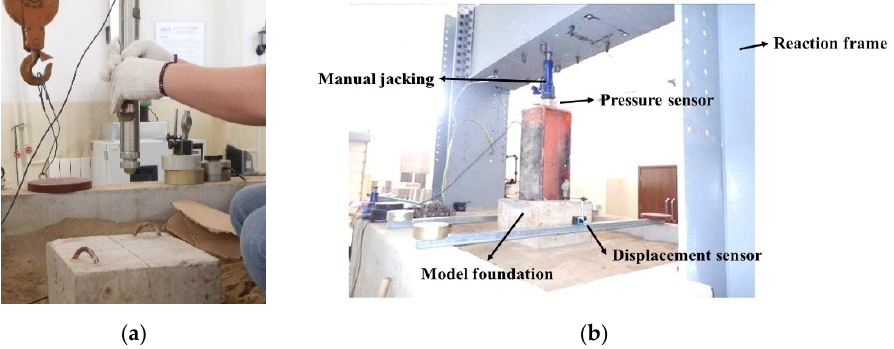
Figure 4. Test equipment: ( a ) impact steel bar; ( b ) equipment and sensors for the SLT. The SLTs were performed using the laboratory reaction frame and a 10 t manual jack.